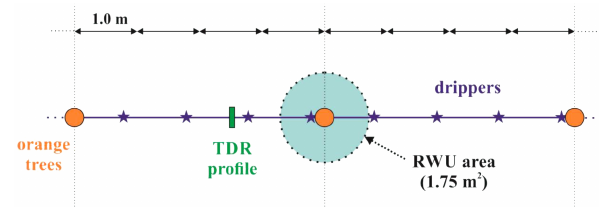
Figure 9. Scheme of the experimental field with the location of the main sensors. The radius of the root water uptake (RWU) zone, as- sumed to be circular, is equal to about